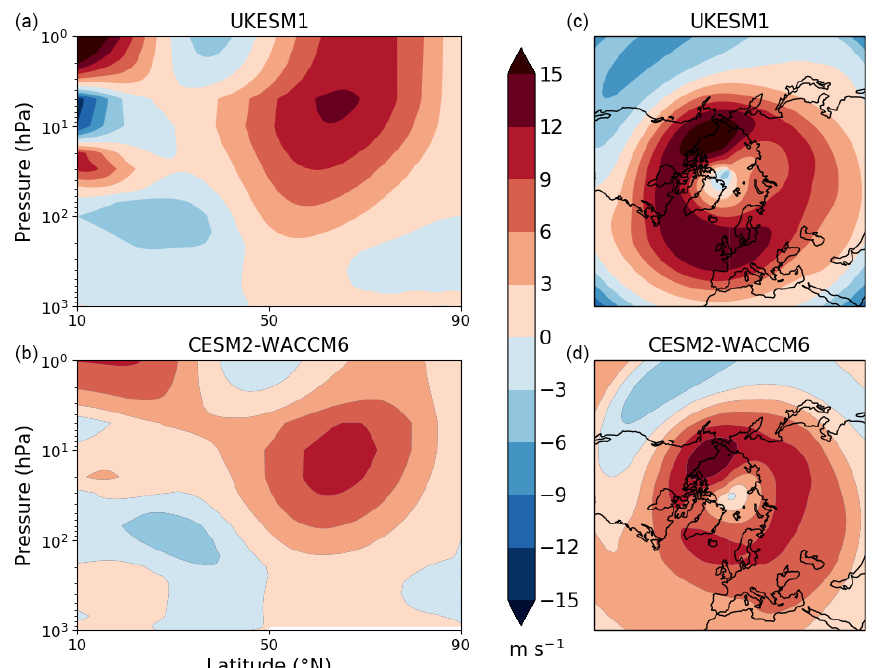
Figure 5. The perturbation to mean December–February zonal wind speed over 2081–2100 (ms − 1 ) caused by SAI, diagnosed from { G6sulfur minus G6solar } . Panels (a) and (b) show the change in Northern Hemisphere zonal wind, with positive values indicating a westerly pertur- bation and negative values an easterly one. Panels (c) and (d) show the spatial distribution of this change at 10hPa which is the level of maximum perturbation. Panels (a) and (c) show results from UKESM1, panels (b) and (d) those from CESM2-WACCM6.